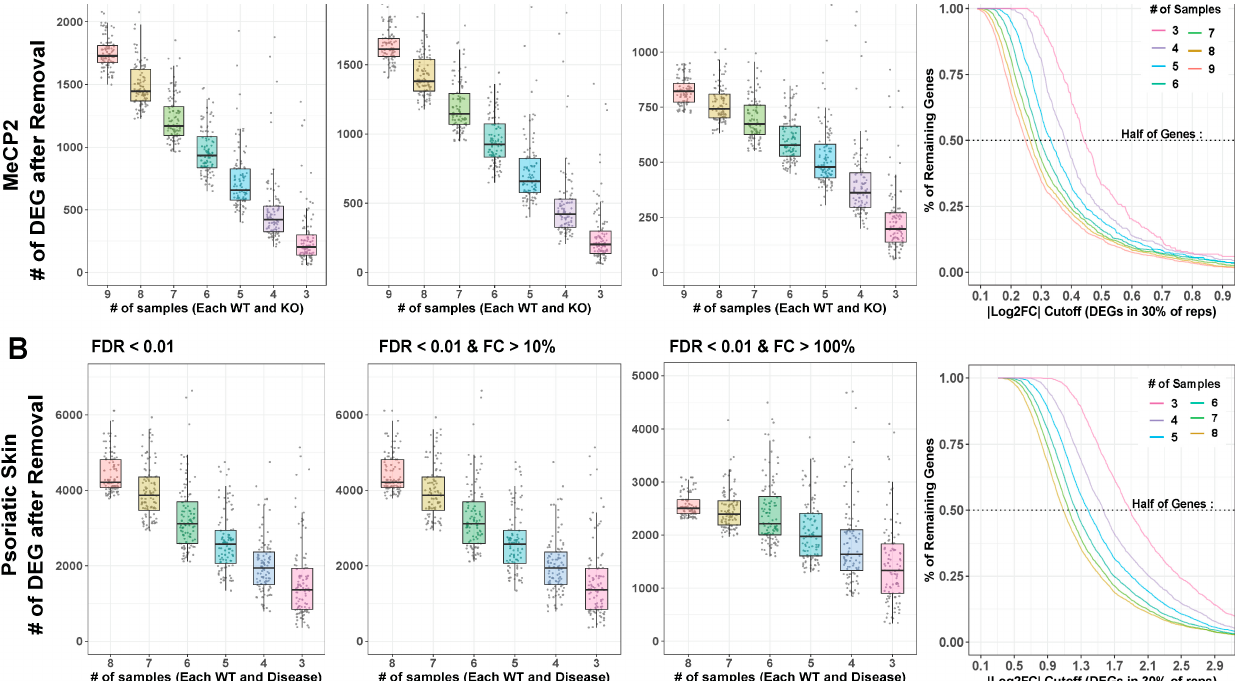
Figure 5. Downsampling analysis. ( A , B ). Large contrasts from MeCP2 and lesional psoriatic skin data were downsampled to smaller and more common experimental sample number, and DEG analysis was run on these subsets. Box plot and jitter points are plotted for resultant DEG numbers under each condition. Cutoffs for MeCP2 are sample numbers 9 through 3. Cutoffs for psoriatic data are sample numbers 8 through 3. Each cutoff number was repeated 100 times, with random samples discarded each time. Results are plotted at FDR < 0.01. MeCP2 data are fold change (FC) cutoff at any FC, FC > 10%, and FC > 20%. Psoriatic skin data are FC cutoff at any FC, FC > 10%, and FC > 200%. Curves indicate the percent of DEGs remaining at continuous |log2 fold change| cutoffs. Horizontal line indicates 50% of genes removed.